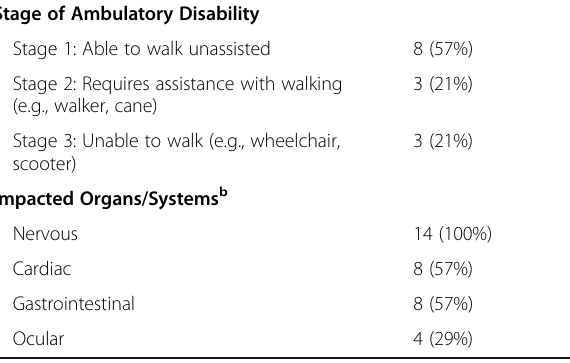
Table 2 Demographic and disease characteristics of study sample